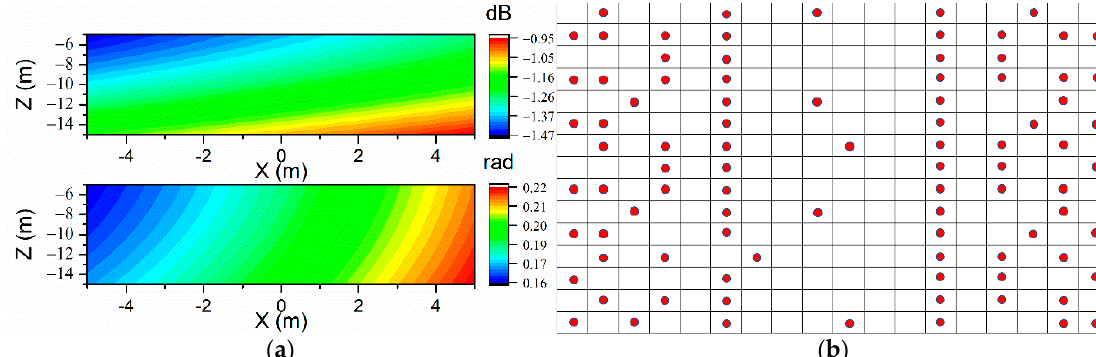
Figure 13. The sound prediction errors of VR-ESM on the prediction plane in the free field at the frequency of 71 Hz, L 1 = 42. ( a ) Upper: p E ; lower: ϕ E . ( b ) The arrangement of measurement points (90 points optimized with EFI).